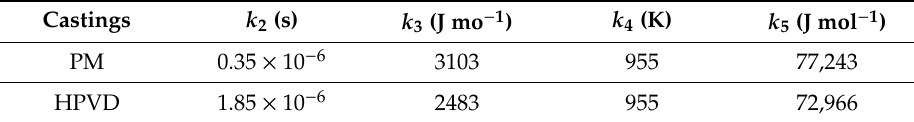
Table 2. Coe ffi cients for TTP diagram of HPVD and PM.